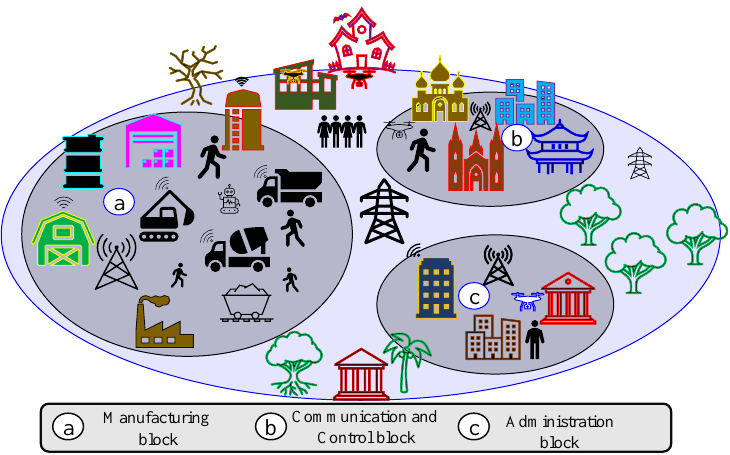
Figure 3. ABC Ltd. Scenario.